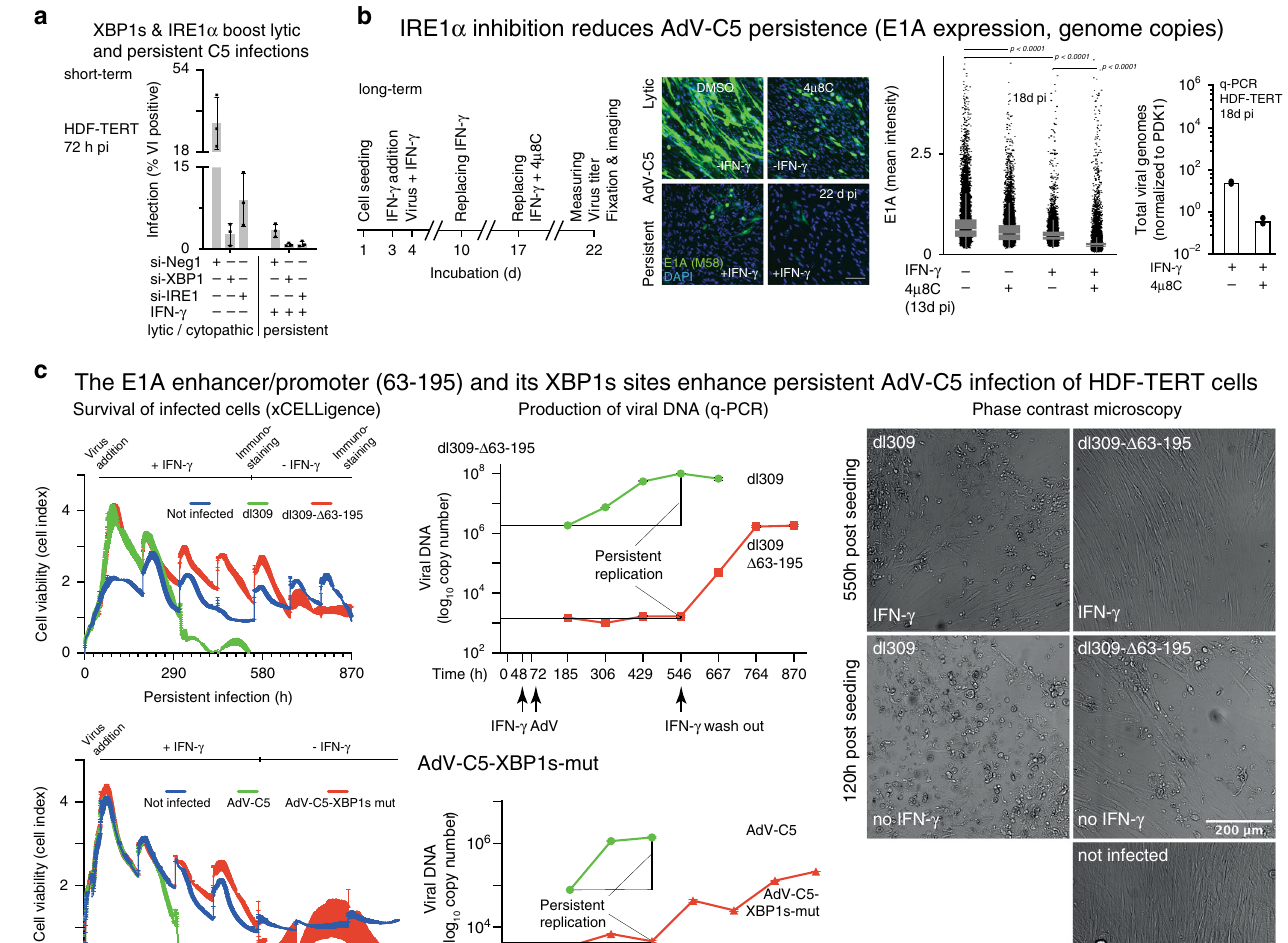
immunoprecipitations and split-GFP complementation assays. This mode of IRE1 α activation contrasts with a recent lipid stress activation model of IRE1 α , where BiP binding to IRE1 α is not affected 43,67 . Importantly, IRE1 α activation by C2 19K was independent of 19K interaction with MHC-I in the ER